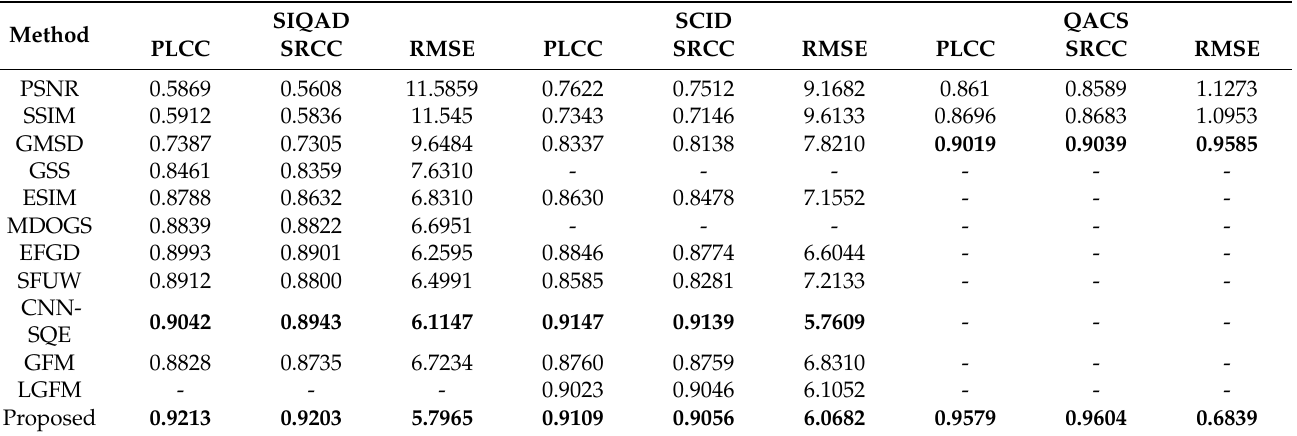
Table 1. Performance comparison results of different FR-IQA methods on the SIQAD, SCID, and QACS